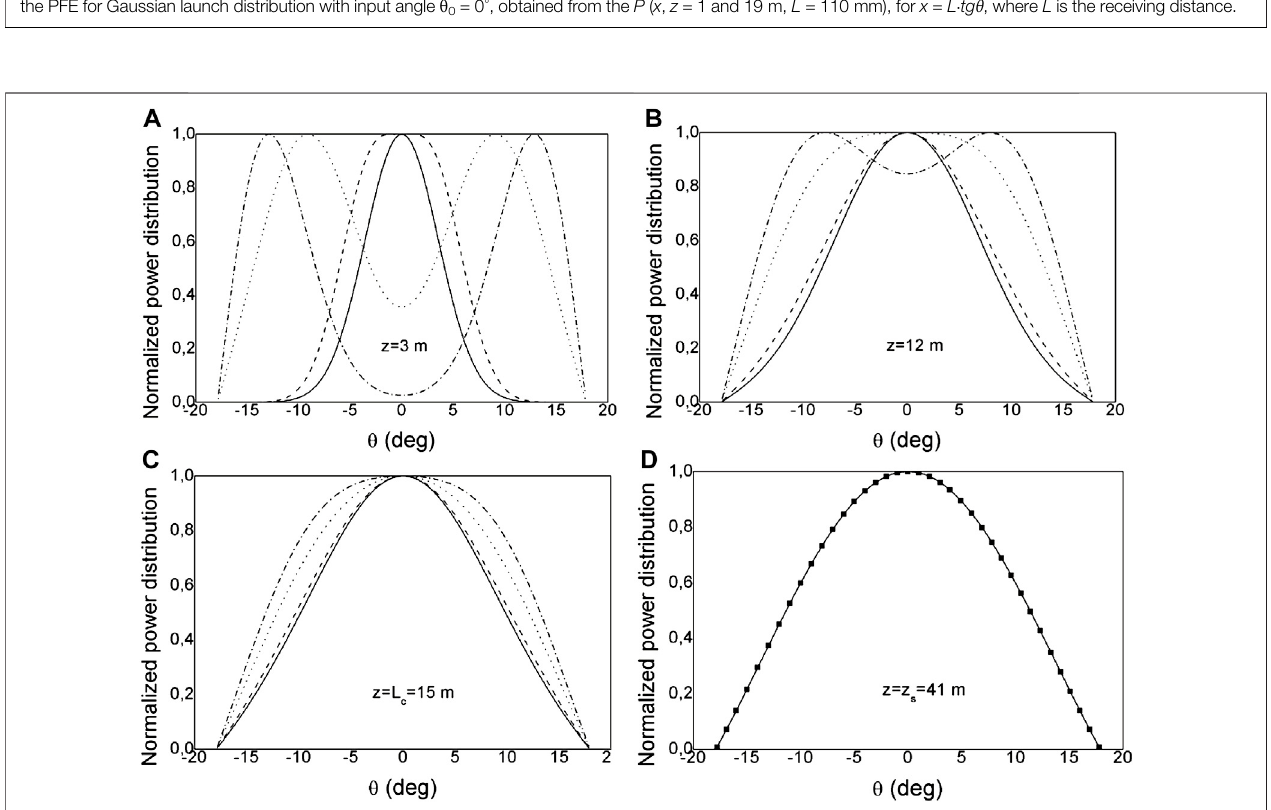
FIGURE 4 | The normalized angular power distribution at the end of PMMA SI MM POF, obtained by solving the PFE for four Gaussian launch distributions with input angles